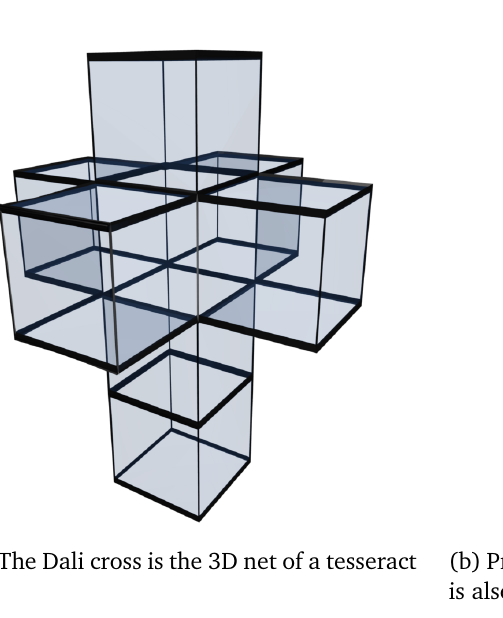
Figure 3: How the net of a cube folds into a